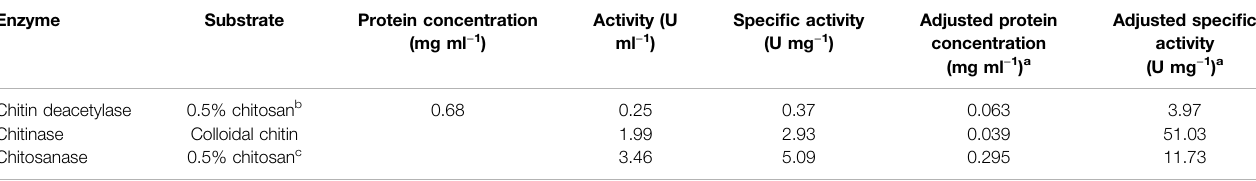
TABLE 3 | Enzymatic activity determined in the post-culture liquid obtained after expression of the pCHIT transformants.